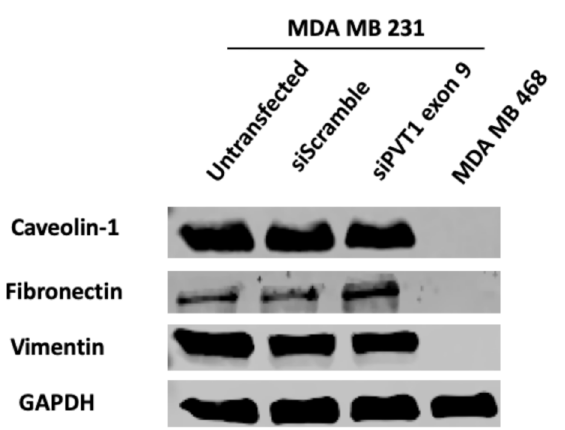
Figure 7. SiRNA targeting of PVT1 exon 9 does not affect EMT in MDA MB 231 CL TNBC cells. MDA MB 231 CL TNBC cells were transfected with PVT1 exon 9 specific siRNAs (siPVT1 exon 9) for 24 h. Western blotting was performed using specific antibodies against vimentin, caveolin and fibronectin. When compared to MDA MB 231 CL TNBC cells transfected with only control scramble non-targeting siRNA (siScramble). siRNA targeting of PVT1 exon 9 did not change the expression of EMT markers in MDA MB 231 CL TNBC cells, except for a slight increase in